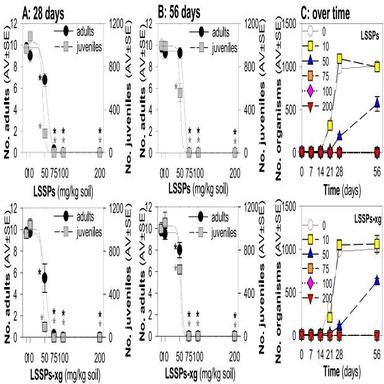
Results in terms of survival and reproduction when exposing Folsomia candida in LUFA 2.2 soil to LSSPs (Lipid Surfactant Submicron Particles) and LSSPs-xg (LSSPs without stabilizer xanthan gum) during (A) 28 days (OECD Standard), (B) 56 days (extension for 2nd generation), and (C) overview of the time series sampling at days: 7, 14, 21, 28 and 56 days. Values represent number of adults, juveniles, and population as average ± standard error (AV ± SE). \: p < 0.05 (Dunnett's).